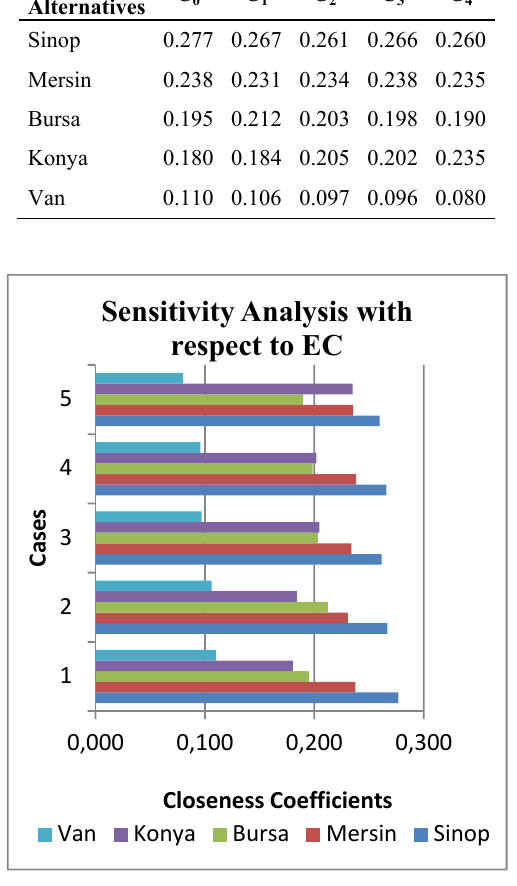
Fig. 6 Sensitivity Analysis with respect to EC considered cases According to sensitivity analysis results, in all considered cases, the closeness coefficients of the strategic alternatives: Sinop and Mersin stays same. On the other hand, the closeness coefficient of Van decreases as the external criterion earthquake risk